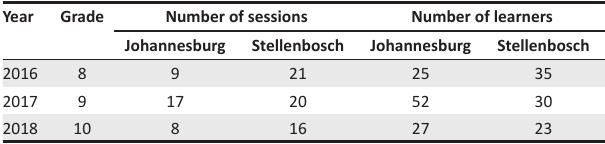
TABLE 1: Club sessions and learners.